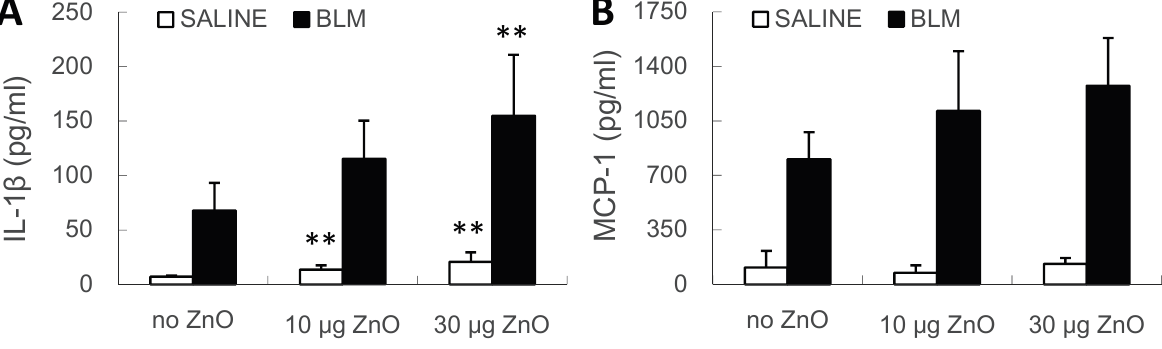
Figure 4. Cytokine levels in BALF. Mice were exposed to ZnO nanoparticles with or without BLM treatment. ( A ) IL-1 β and ( B ) MCP-1 levels in BALF were determined at Day 10 after administration. The number of mice was six in the SALINE-no ZnO, seven in the SALINE-10 µg of ZnO, six in the SALINE-30 µg of ZnO, six in the BLM-no ZnO, six in the BLM-10 µg of ZnO and seven in the BLM-30 µg of ZnO group. Data are mean ± SD; ** p < 0.01; compared to vehicle